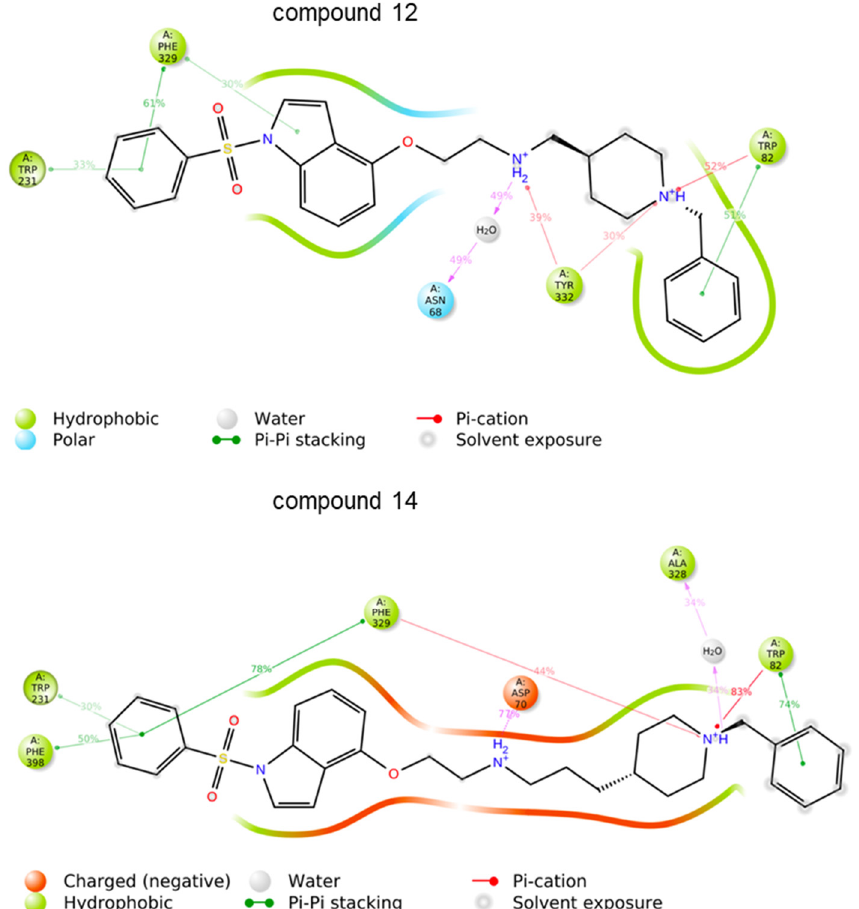
Figure 3. Ligand–protein interactions of compound 12 (up) and compound 14 (down) with BuChE. Notable dissimilarities regarding the pivotal salt bridge between Asp70 in the PAS and the secondary amine of the linker as well as the π - π stacking formed by Trp82 in the mid-gorge of BuChE are presented. The persistence of each contact is represented as the participation percentage of the whole simulation time, seen as a value above the arrow depicting particular